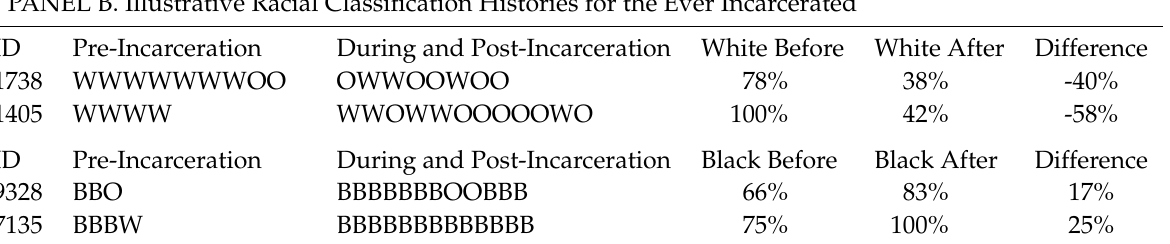
PANEL B. Illustrative Racial Classification Histories for the Ever